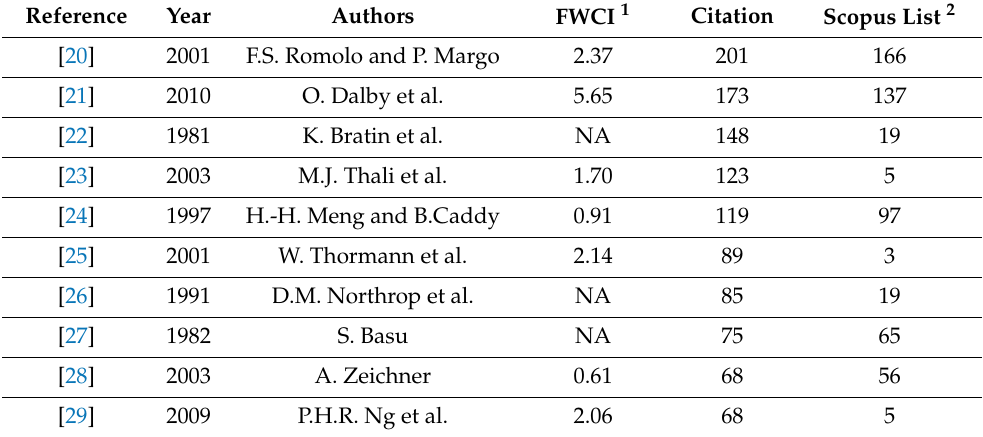
Table 2. Most cited publications; Scopus search all year to 2018: gunshot AND